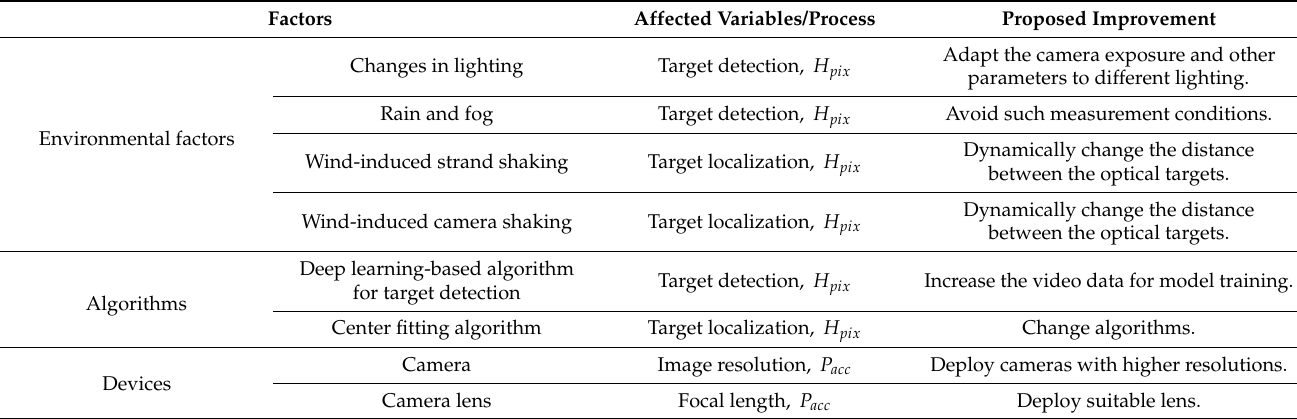
Table 1. Factors affecting the calculation of the cable height difference.